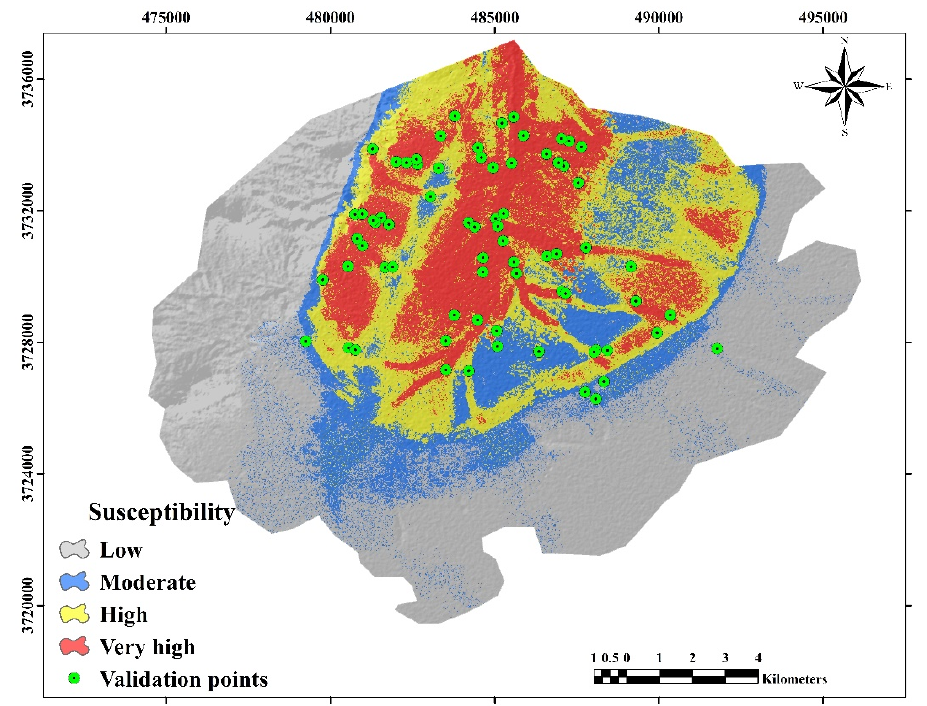
Figure 7. Gully erosion susceptibility map using the RF model.